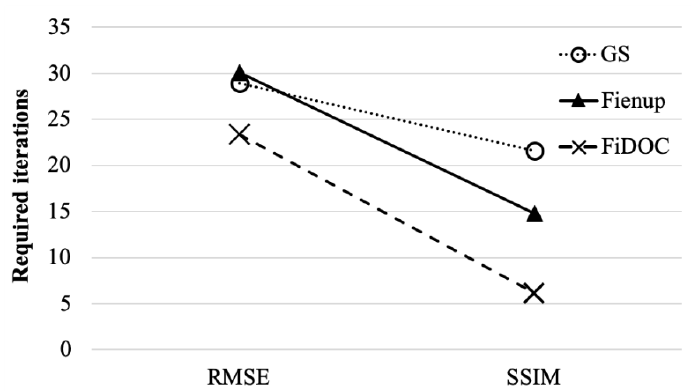
Figure 12. The average number of iterations required for GS, Fienup and FiDOC algorithms based on RMSE and SSIM.